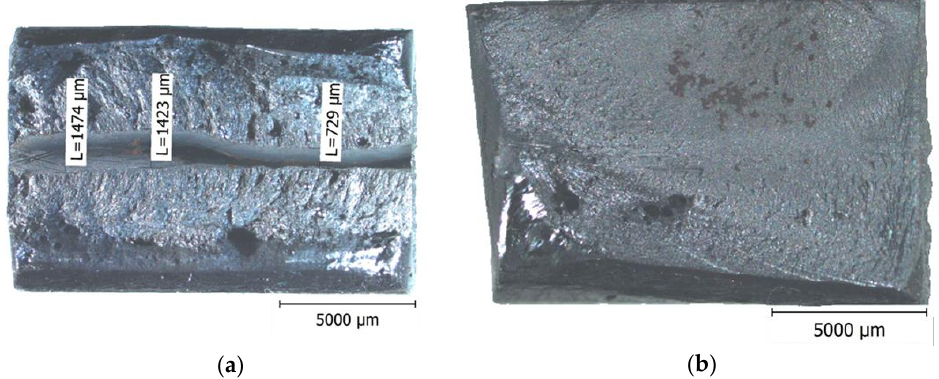
Figure 10. (a) Fatigue crack initiation on the weld defect in the center and ( b ) the fracture surface without weld defects — initiation on the top side of the